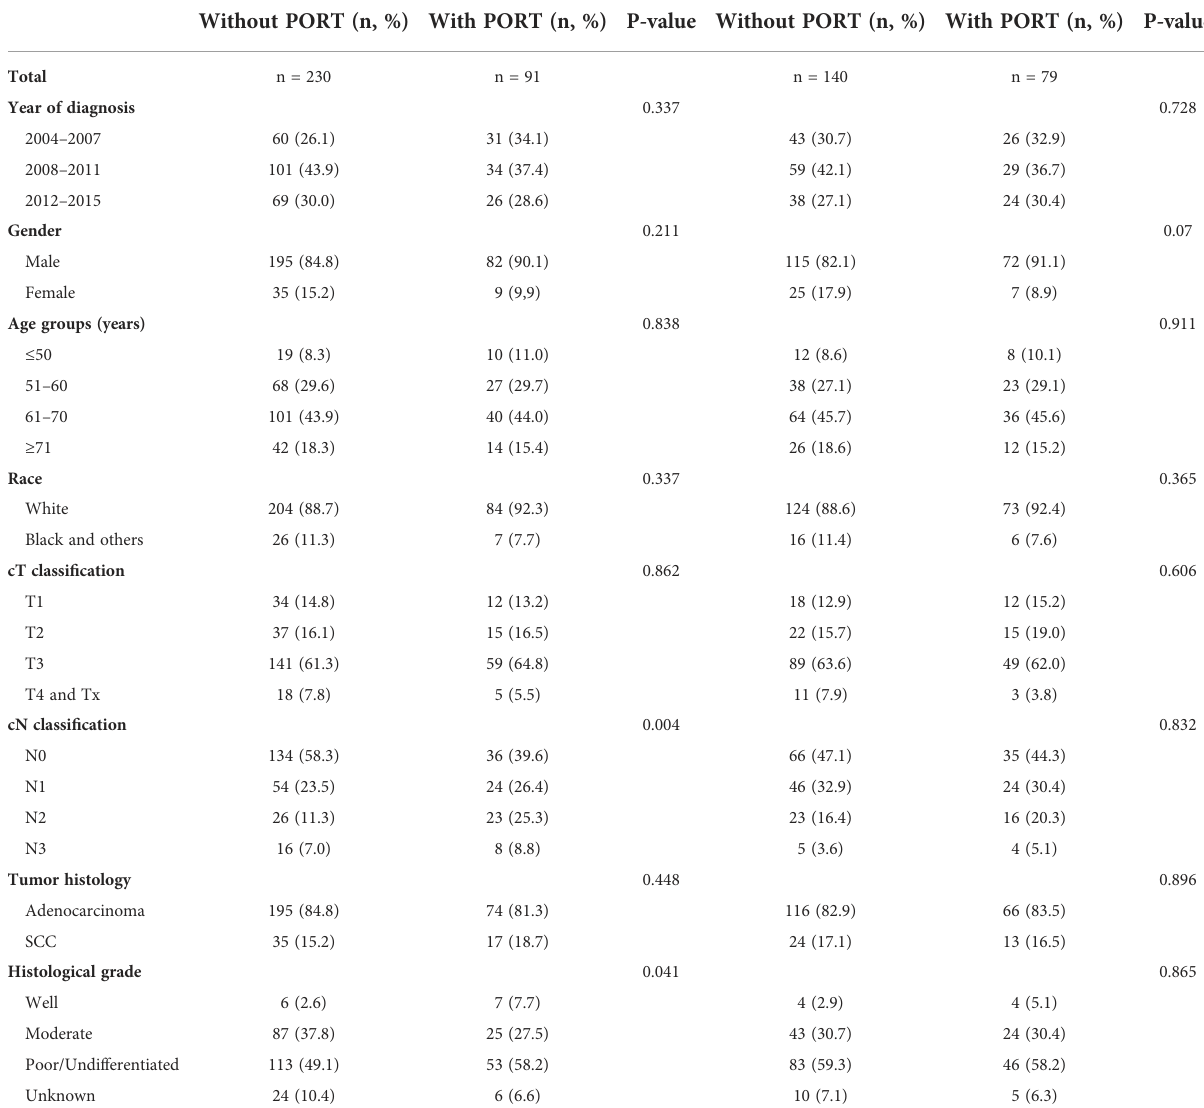
TABLE 1 Baseline characteristics of patients included in the analysis before and after PSM. Characteristic Before PSM After